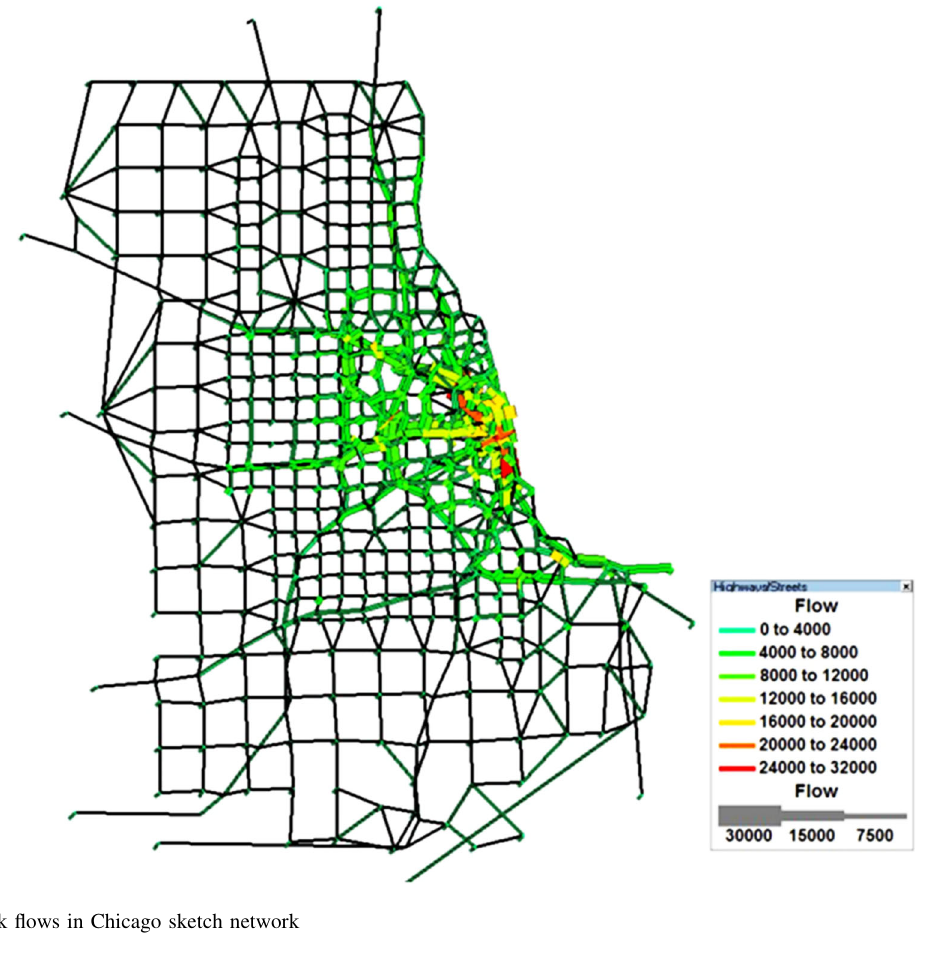
Fig. 12 Total link flows in Chicago sketch network